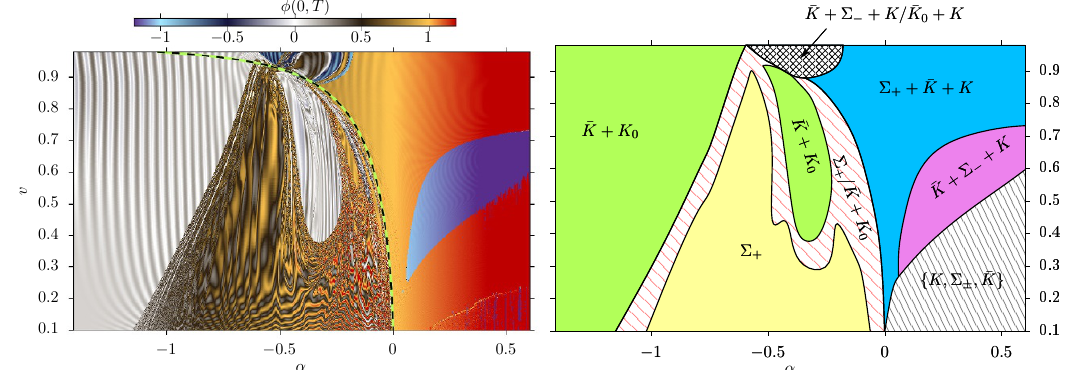
Figure 28 . Di(cid:11)erent scenarios of antikink-(kink-on-impurity) ( (cid:22) K + K 0 ) collisions. The left plot shows the (cid:12)eld value at center at time T after the collision. The right plot shows the products of the collisions. Line (cid:12)lled regions correspond to chaotic